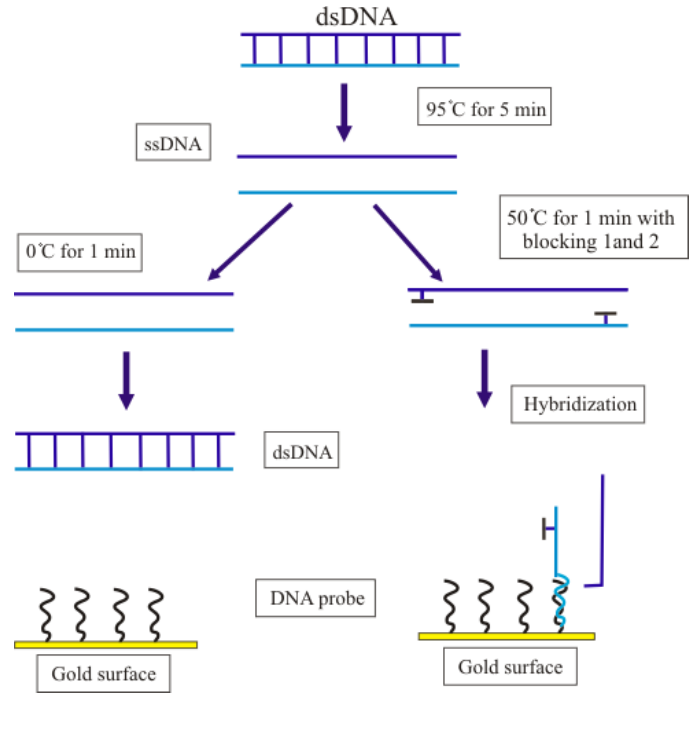
Figure 6. Schematic diagram of denaturation method. The bacteria dsDNA was denatured to ssDNA before hybridization with the DNA probe. Left: simple thermal denaturation, 95 °C for 5 minutes and on ice for 1 minute. Right: simple thermal denaturation plus blocking oligonucleotides, 95 °C for 5 minutes and cooled down at 50 °C for 1 minute to anneal the blocking